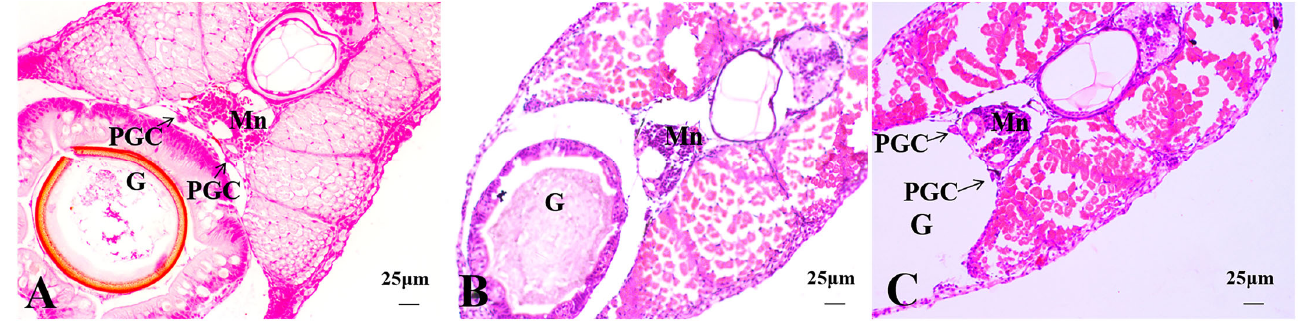
Figure 3. Histological images of the gonads of loaches at 15 dph. ( A ): diploid loach; ( B ): hybrid triploid loach without gonads; ( C ): hybrid triploid loach; G: digestive tract; Mn: middle kidney; PGC: primordial germ cell.